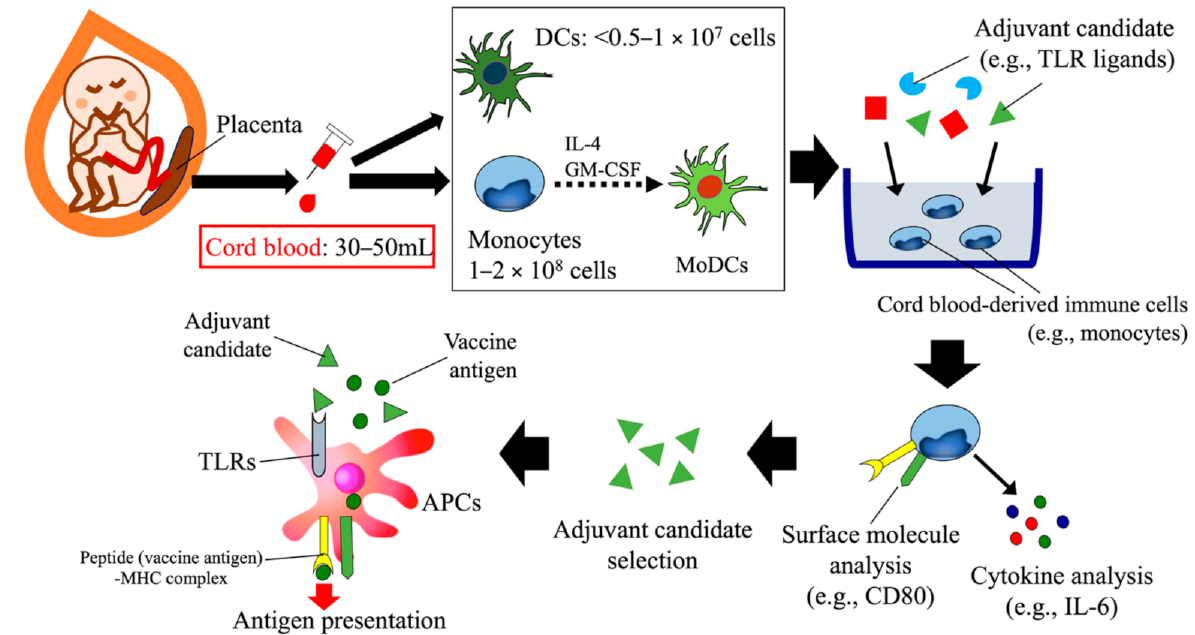
Figure 2. Concept of the human cord blood-based development of vaccine adjuvant candidate. Immune cells (monocytes, DCs, and MoDCs) derived from cord blood can be used to study the innate system of human neonates. These cells can be used in in vitro tests to assess the ability of various substances to induce favorable immune responses (e.g., IL − 6 production and CD80 expression). In particular, these tests can identify neonate- and infant-specific adjuvant candidates that effectively activate APCs to induce vaccine antigen-specific protective immunity. DC, dendritic cell; MoDC, monocyte-derived dendritic cell; TLR, toll-like receptor; APC, antigen-presenting cell; IL − 6, interleukin −